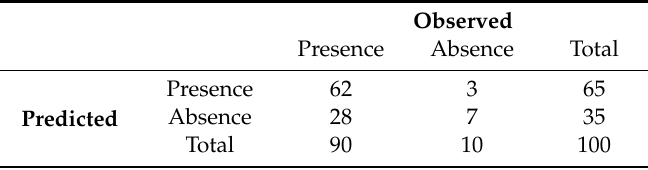
Table 3. Confusion matrix for glossy buckthorn occurrence estimated from temporal linear unmixing of the Landsat-8 OLI normalized di ff erence vegetation index (NDVI) image series. The threshold value (% cover) was used to determine if glossy buckthorn was present if the endmember fraction map was set to 0.4 (minimum glossy buckthorn cover measured value in presence plots was 27%).